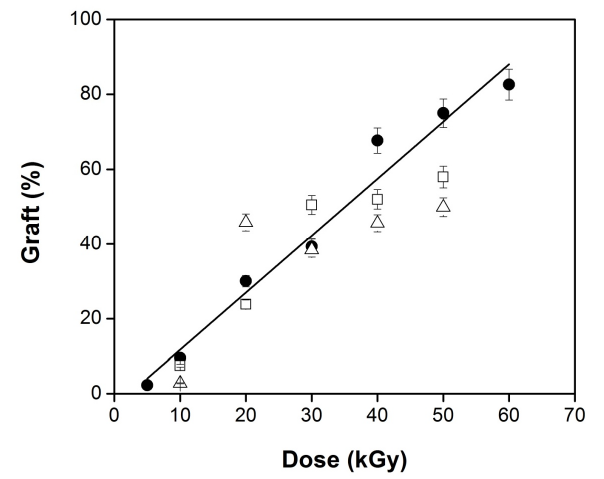
Figure 2. Grafting yield by one step method of PNVCL and PNVIM onto SR films in toluene as function of irradiation dose, at dose rate of 9.3 kGy h − 1 and different monomer concentration: 50% monomer in toluene (NVCL/NVIM 1/1, vol%) (  ); 50% monomer in toluene (NVCL/NVIM 7/3, vol%) (  ); and 100% monomer (NVCL/NVIM 1/1, vol%) ( 